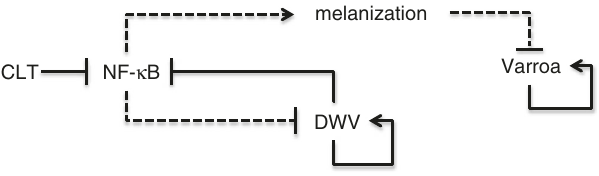
Fig. 5 The network of the observed interactions among different stress agents. Clothianidin (CLT) contamination decreases NF- κ B activation, impairing the immune response and enhancing mite ’ s fi tness, as a possible consequence of a higher feeding ef fi ciency. The decrease in NF- κ B activation relaxes immune control on DWV, which, above a certain threshold, impacts NF- κ B, reinforcing the negative effect on immune response. Arrows indicate positive (i.e., stimulation or upregulation) interactions; bar-headed lines mark negative interactions (i.e., inhibition or downregulation); dashed lines indicate that the effect can be impaired by